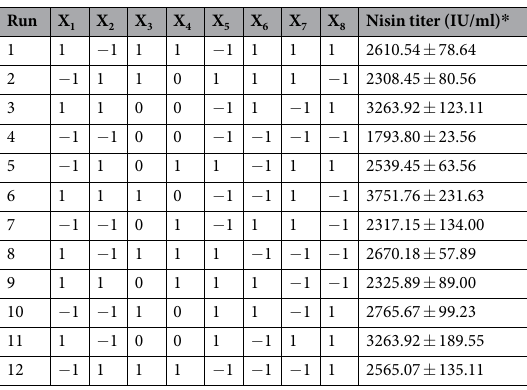
Table 2. Plactkett-Burman design variables (in code levels) with nisin titer as response (8 h anaerobic fermentation at 30 °C). * Values were given by mean ± standard deviation (n =